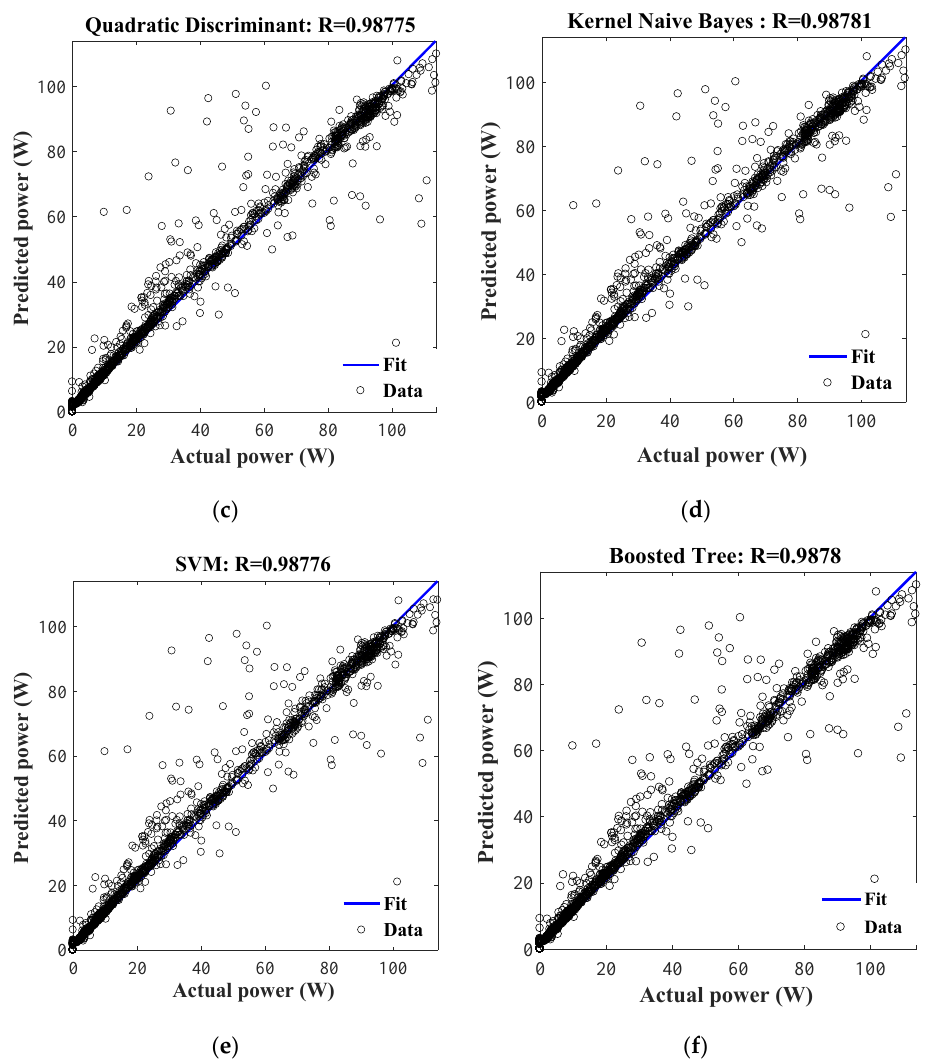
Figure 13. Linear regression of targets and outputs for each classification algorithm. ( a ) Coarse Tree; ( b ) Cubic KNN; ( c ) Quadratic Discriminant; ( d ) Kernel Naïve Bayes; ( e ) Gaussian SVM; ( f ) Boosted trees. Table 4. R and normalized mean absolute error (NMAE) related to six classification